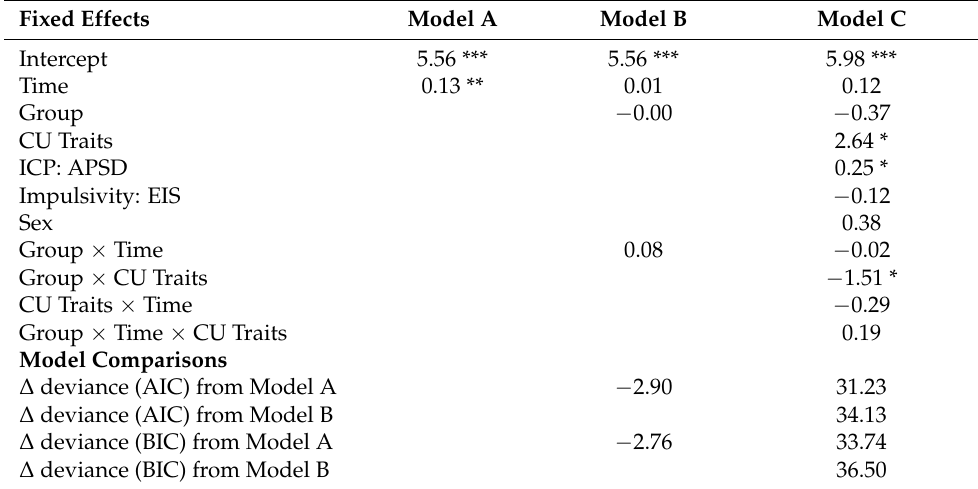
Table 4. Fixed Effects and Comparison Statistics for Models Predicting FACES Fear